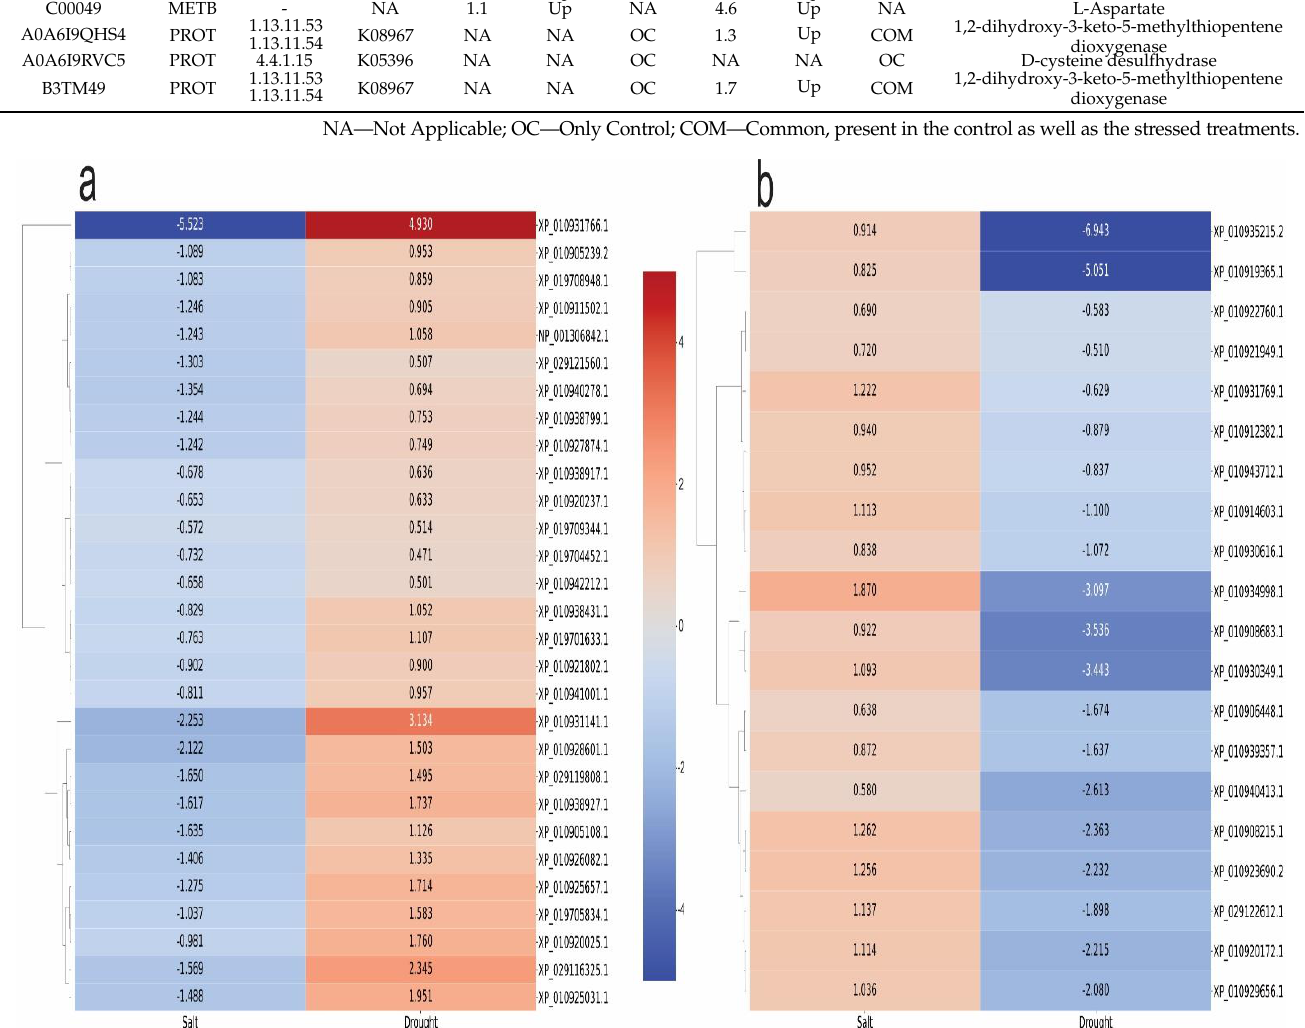
Table 3. Enzymes differentially expressed in the leaf of young oil palm plants under both drought and salinity stresses. Protein ID